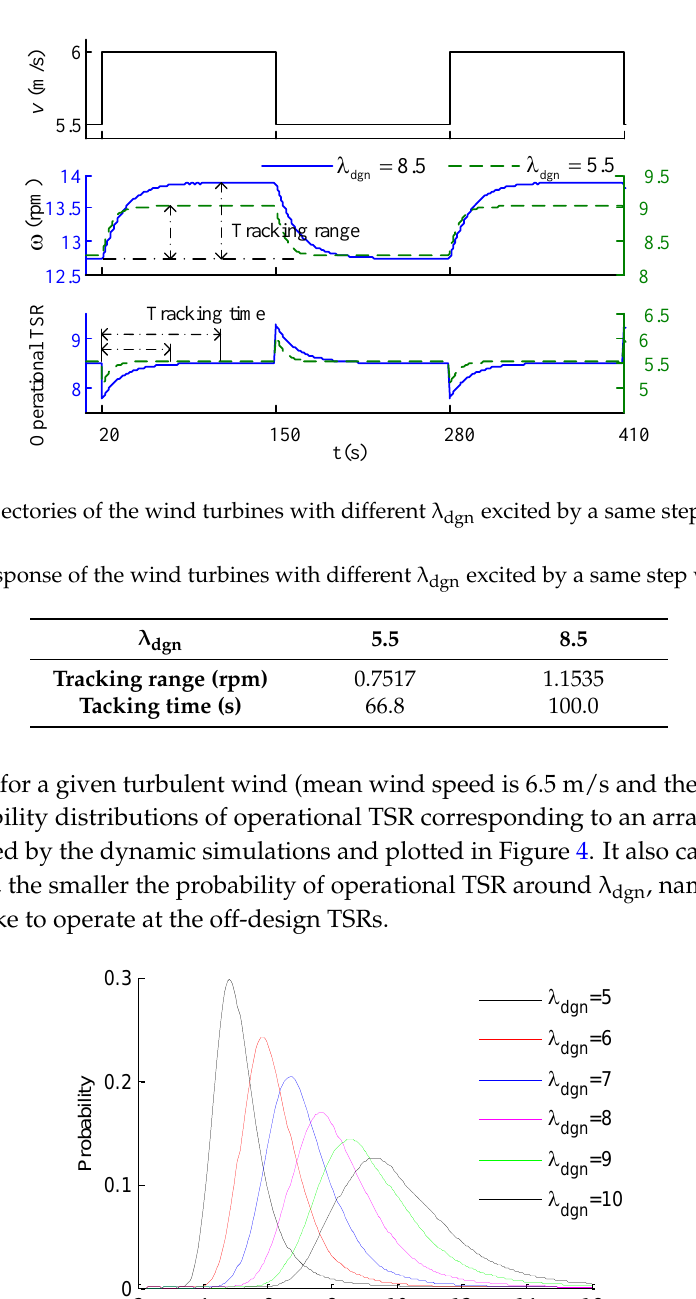
Figure 4. The probability distribution of operational tip speed ratio (TSR) corresponding to an array of λ dgn .